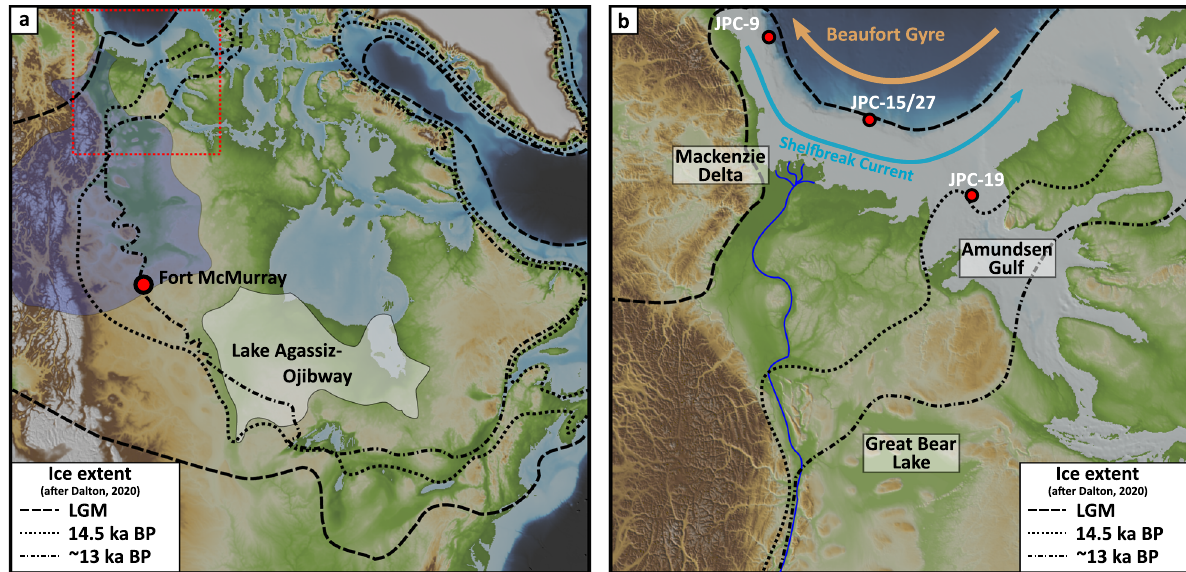
Fig. 1 Overview map of North America and the study area. a Reconstructed ice margins are indicated for climatic key periods (LGM, onset of the Bølling – Allerød warm period at 14.5 ka BP and onset of the Younger Dryas cold period at 13 ka BP) 21 . Blue shaded area indicates the present-day catchment area of the Mackenzie River. The pale gray area depicts the area Lake Agassiz-Ojibway have occupied in the course of the late Deglacial and early Holocene melting history 19 . The red frame highlights the area displayed at expanded scale in panel b. b Detailed map of the Mackenzie Delta region. Core sites investigated in this study are displayed as red circles. Ice margins are the same as in panel a. The blue line indicates the Mackenzie River in its modern bed. The fl ow direction and position of the Shelfbreak Current and Beaufort Gyre are indicated by arrows (light blue and brown, respectively)